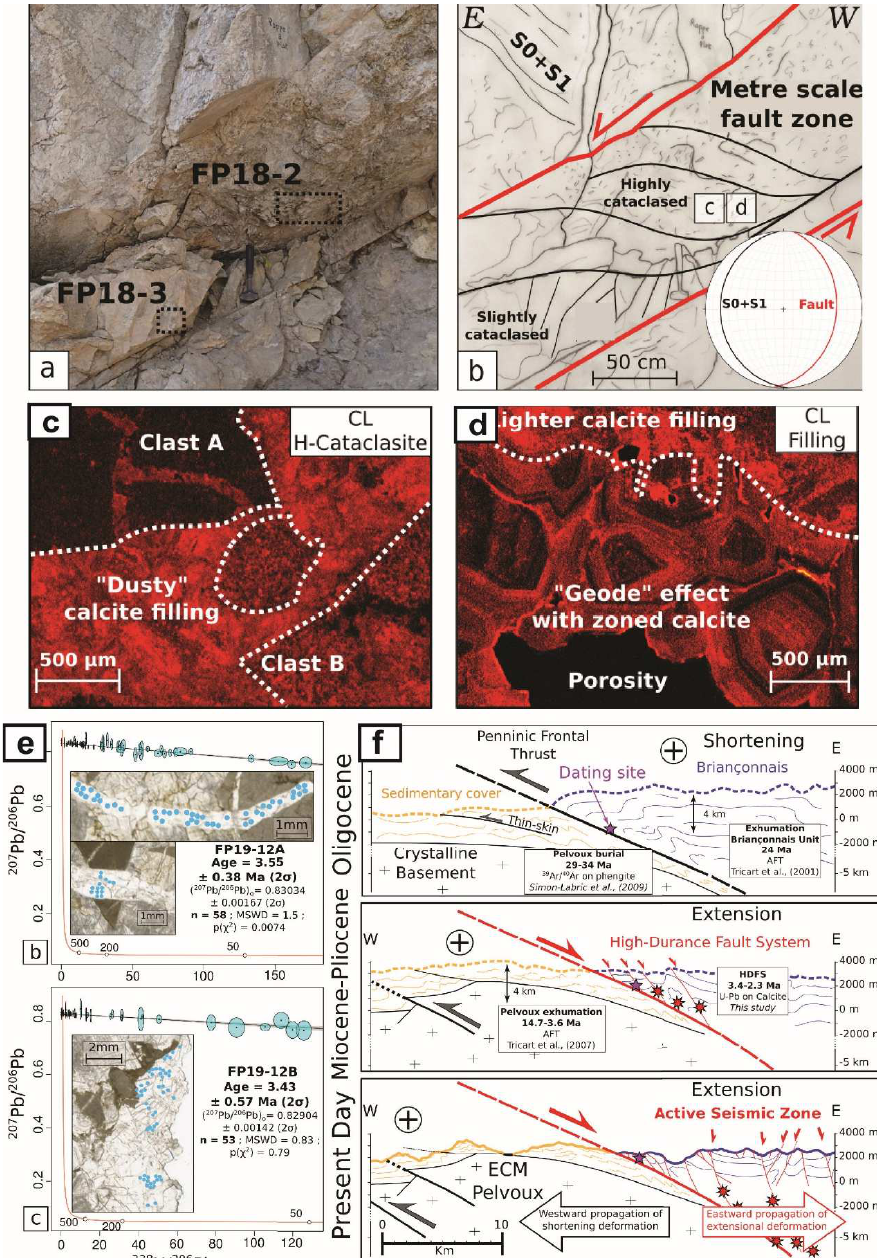
Figure 6. Dated extensional fault in the High Durance Fault System or HDFS [36]. ( a , b ) Outcrop relationship of the east–dipping normal fault zone and cataclasite damage zone. ( c , d ) Cathodolumi- nescence images of the dated calcite showing residual porosity within the cataclasite. ( e ) Example of U–Pb results. ( f ) Reconstructed geodynamic scenario of Penninic Line extensional reactivation and formation of the HDFS.